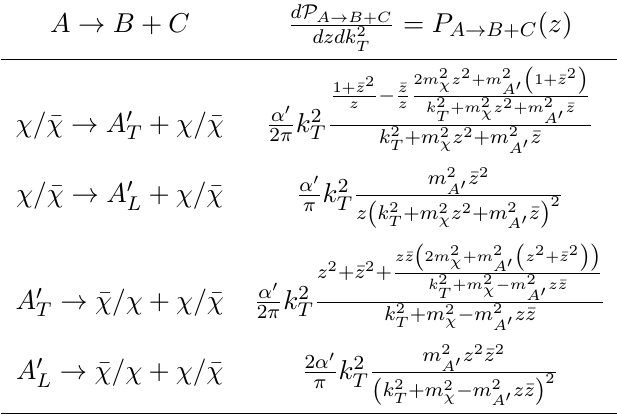
Table 1 . Splitting functions involving χ , ¯ χ , and A 0